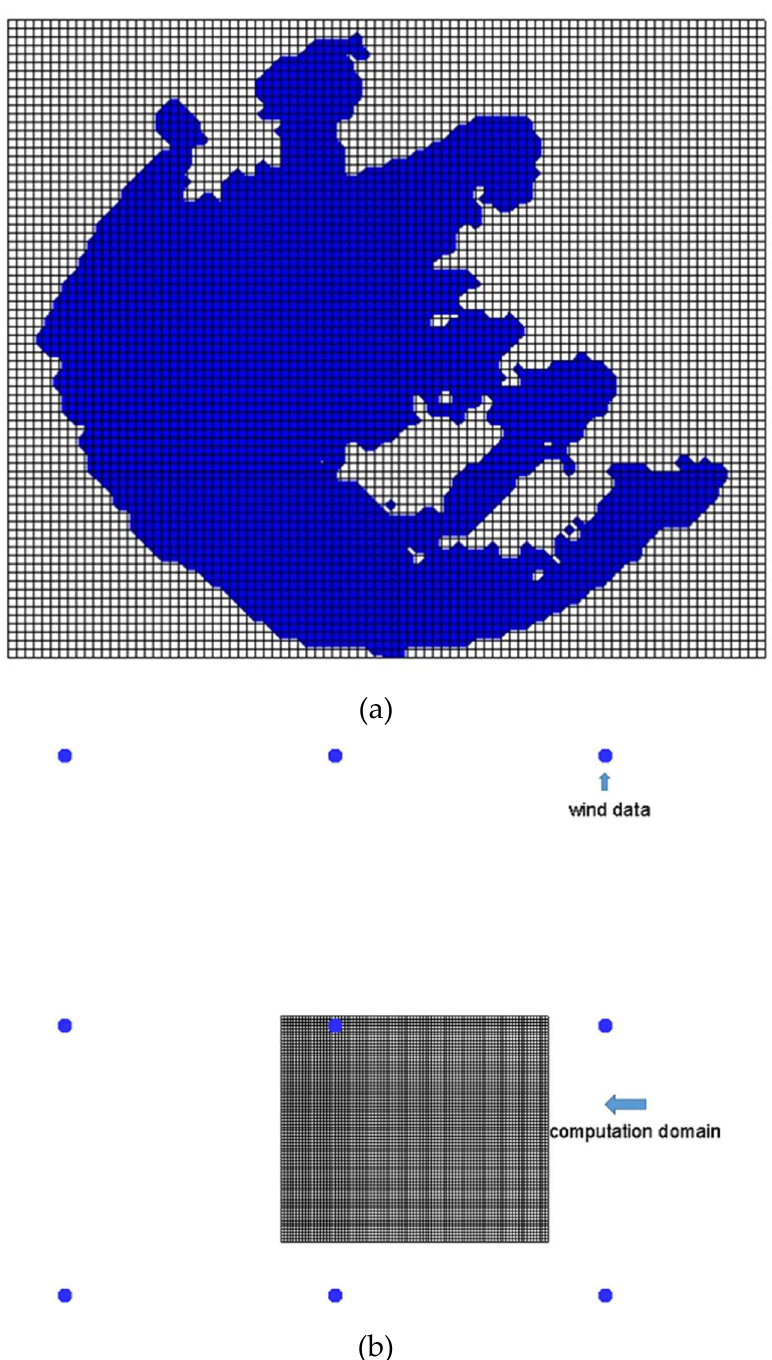
Figure 6. (a) Computational domain of Lake Taihu and (b) Relative location of the computation Figure 6. ( a ) Computational domain of Lake Taihu and ( b ) Relative location of the computation domain and wind velocity data from European Centre for Medium-Range Weather Forecasts (ECMWF).